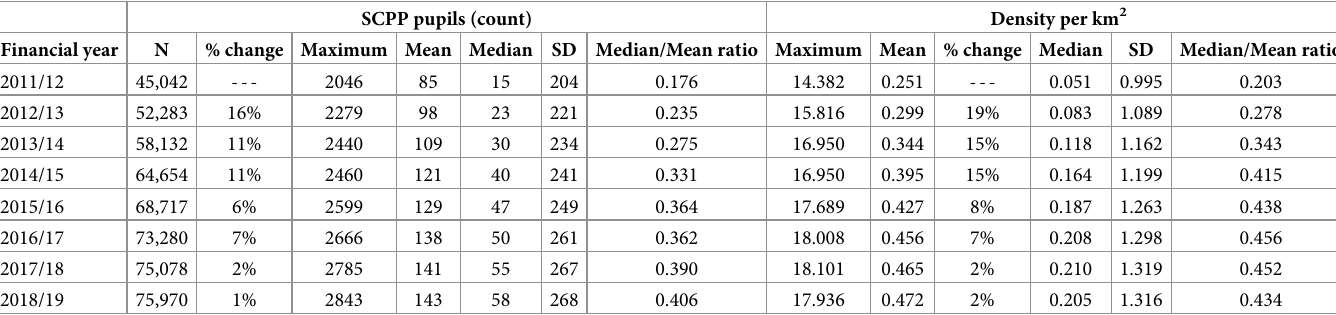
Table 2. SCPP pupils in England at the constituency